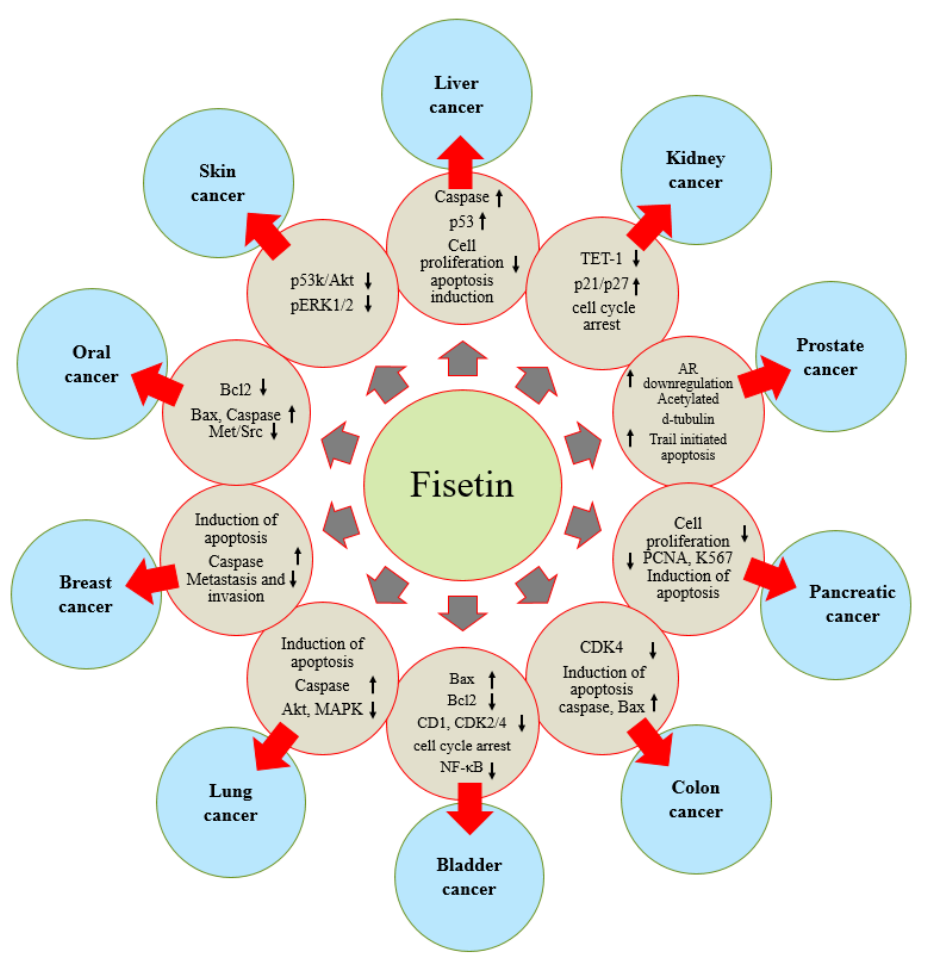
Figure 4. Role of fisetin in prevention of different cancers through modulation of various cell signaling molecules. Up arrow ( ↑ ) indicates upregulation, and downarrow ( ↓ ) indicates downregulation.